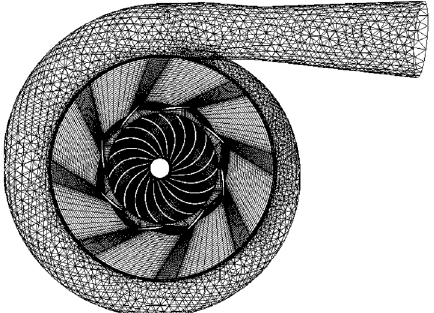
Figure 4: The computational mesh, which includes the impeller, vaned and di ff user sections, and the